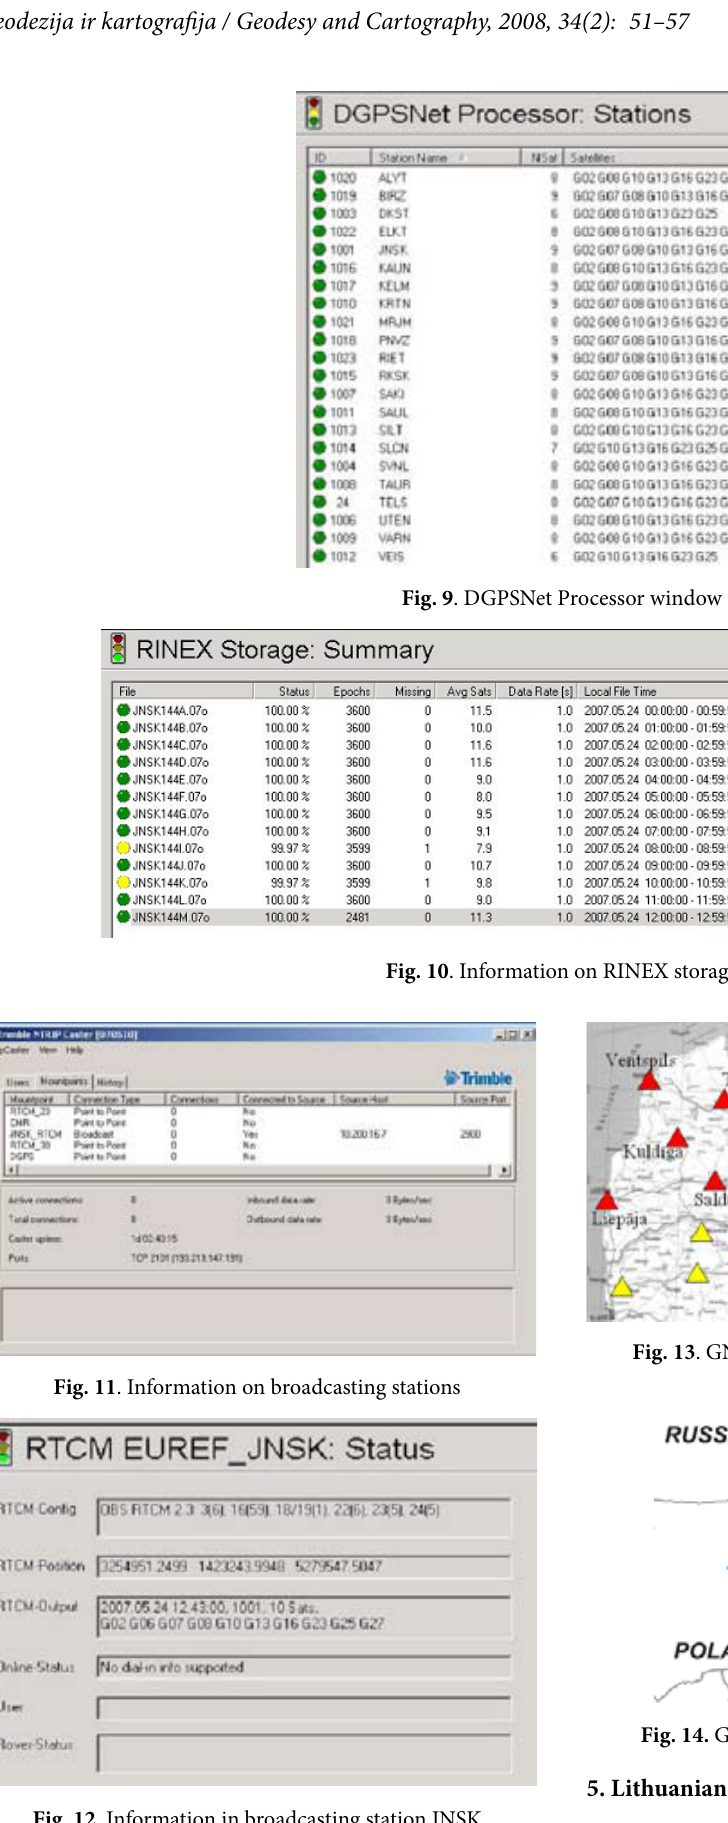
Fig. 12 . Information in broadcasting station JNSK